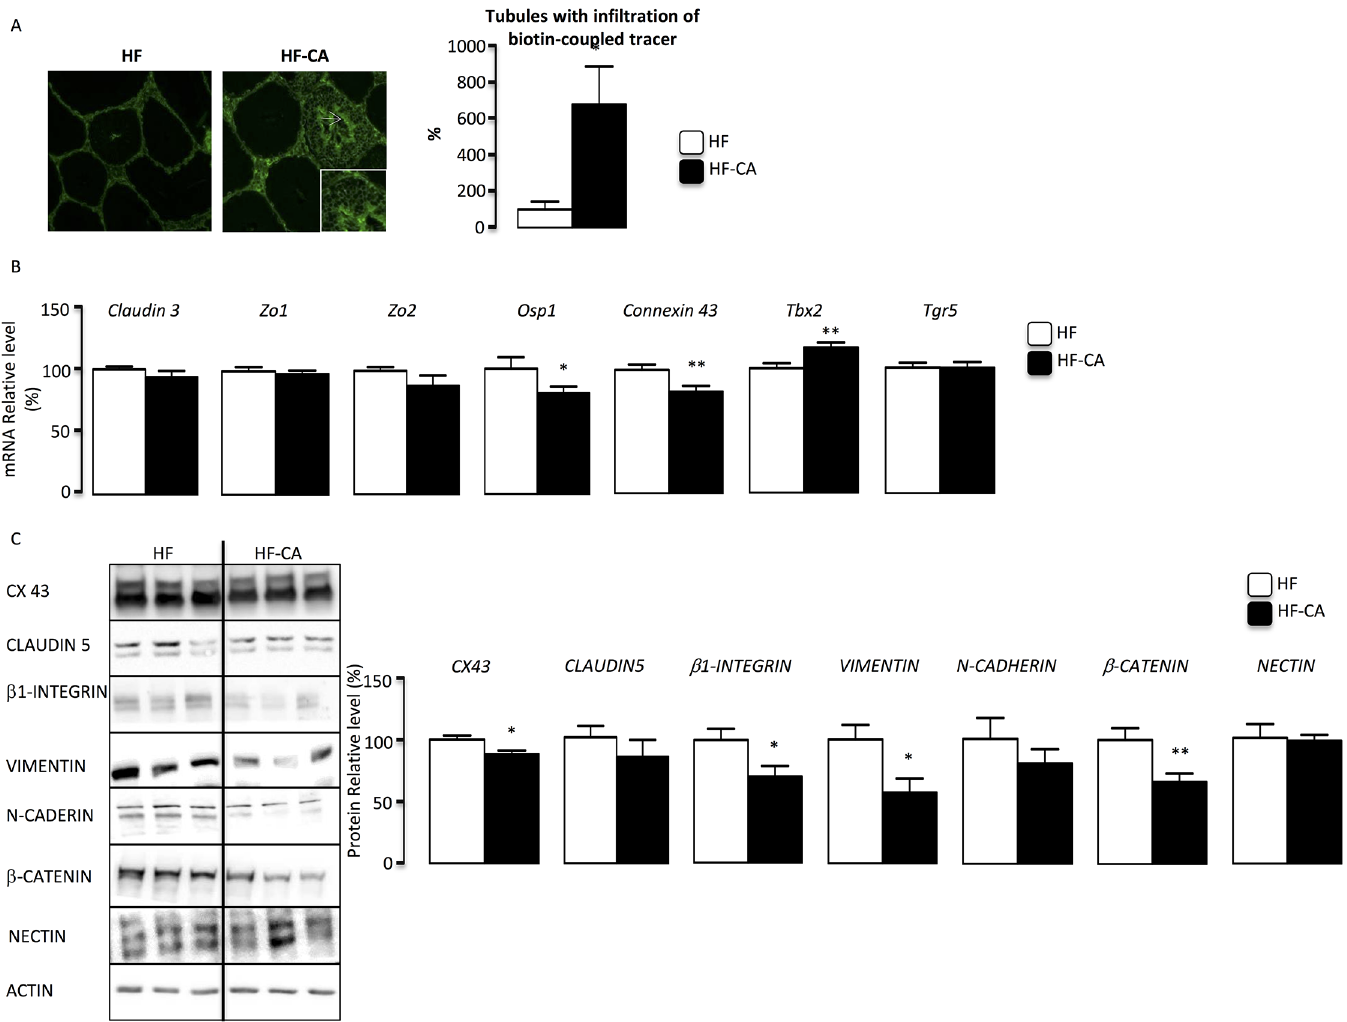
Fig 5. CA-supplementation alters seminiferous epithelium. (A) Blood-testis barrier integrity as measured by the stained testis for EZ-link-biotinylated. Representative micrographs of mice fed HFD or HF-CA diet 4 months after the switch to HF-CA diet. The arrow indicates a tubule with a high intensity of infiltration. The original magnification was X100. Quantification of the number of tubules with infiltration per 100 seminiferous tubules (n = 5 – 12 per group). (B) Testicular mRNA expression of Claudin – 3 , Zo1 , Zo2 , Osp1, Cx 43 , Tbx2 and Tgr5 normalize to β -actin levels in whole testis of C57BL/6 mice fed HFD or HF-CA diet 4 months after the switch to HF-CA diet (n = 16 – 22 per groups). (C) Immunoblot of CONNEXIN43, CLAUDIN5, INTEGRIN β 1, VIMENTIN, N-CADHERINE, β -CATENINE and NECTIN on testicular protein extracts of HFD or HF-CA diet for 4 months (n = 5 – 8 per groups). Quantifications of